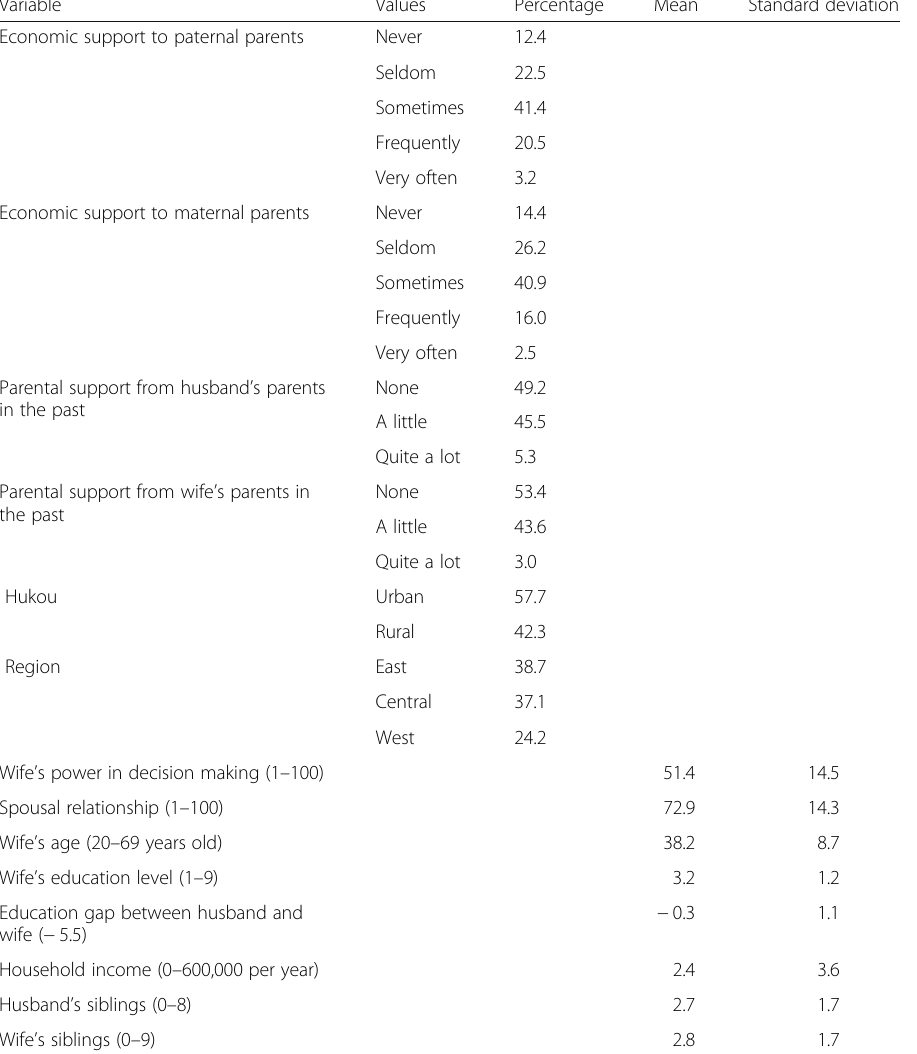
Table 1 Descriptive Statistics on variables N = 1139 Variable Values Economic support to paternal